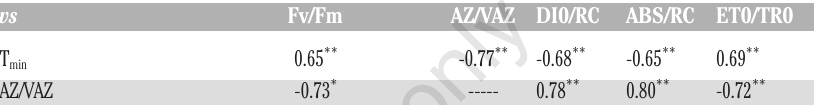
Table 4. Spearman correlation coefficients (r deepoxidation state AZ/VAZ and the fluorescence parameters Fv/Fm, DI0/RC, ABS /RC and ET0/TR0 with Tmin and AZ/VAZ. Correlations between TR with T or AZ/VAZ were not min